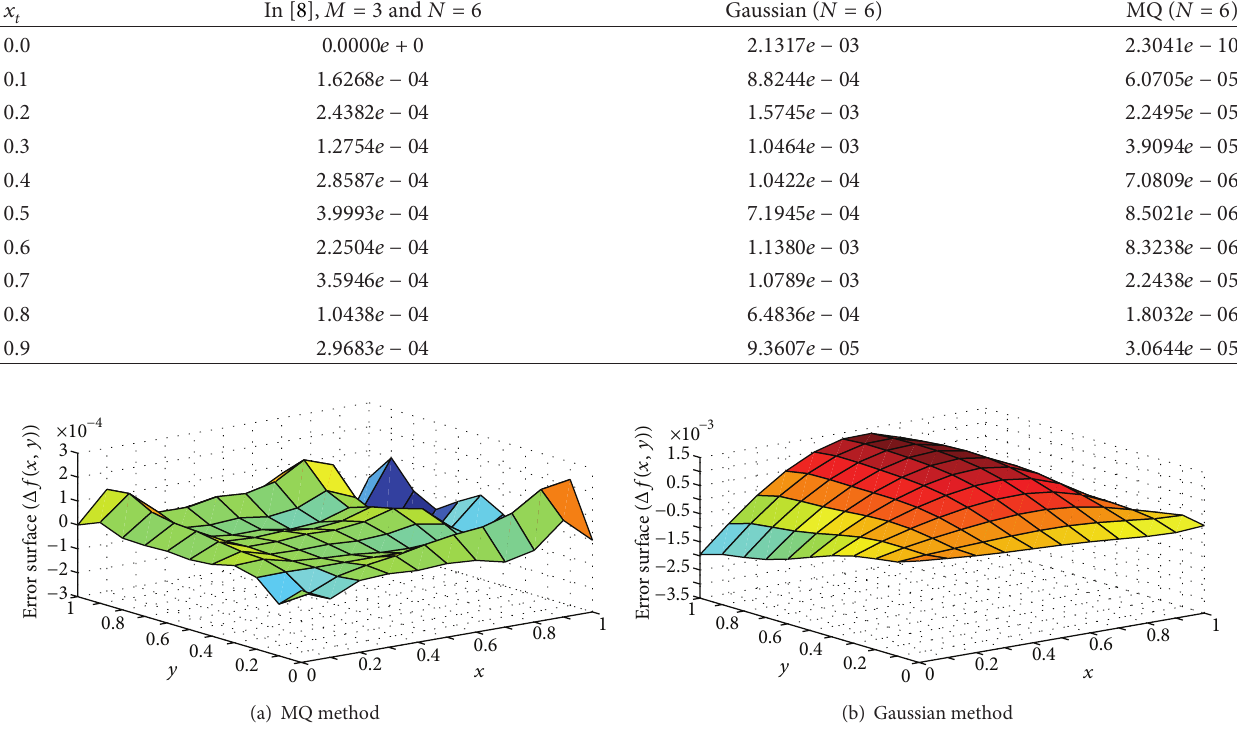
Figure 5: The error surfaces for MQ method and Gaussian method.